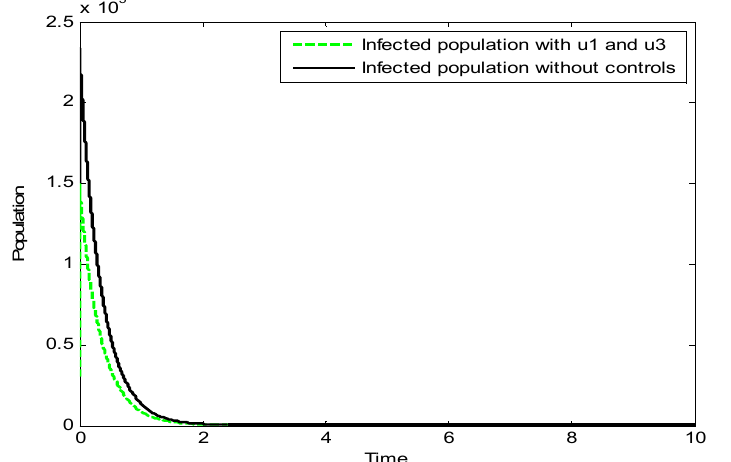
Figure 7. Comparing the dynamics of the infected population without control and with control u 1 & u 3.